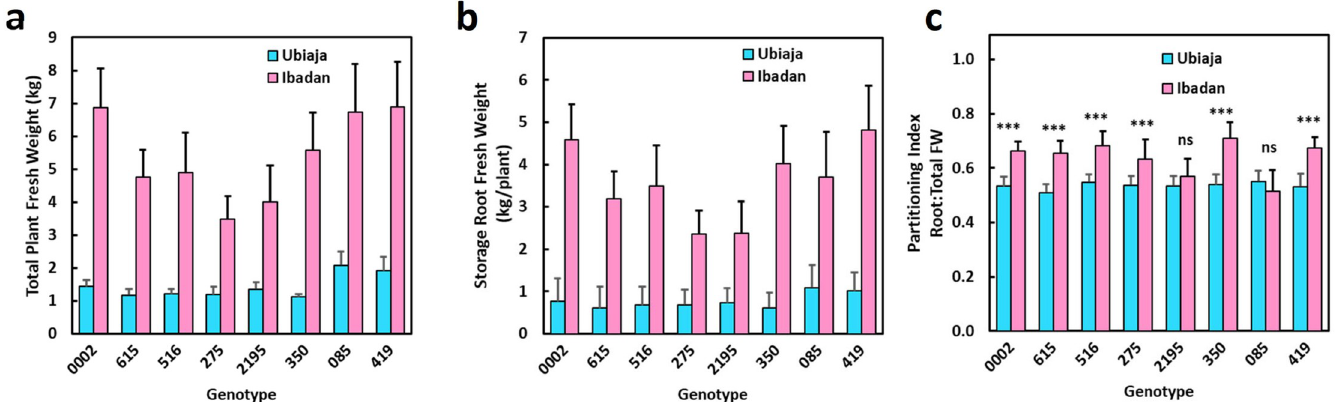
Fig 2. Vegetative growth at six months after planting of eight genotypes in the field experiment at Ubiaja (blue bars) and Ibaden (red bars). a) Total plant fresh weight (above-ground and storage roots); b) storage root fresh weight; c) partitioning index (storage root fresh weight/total plant fresh weight). All pairwise comparisons between locations were statistically significant (p � 0.001) for data in panels a and b. In panel c, comparisons that were not significant (ns) or were significant at p � 0.001 ( ��� ) are labelled. Data for mean partitioning index are reported though data were statistically analyzed on third order transformed (cubed) data.